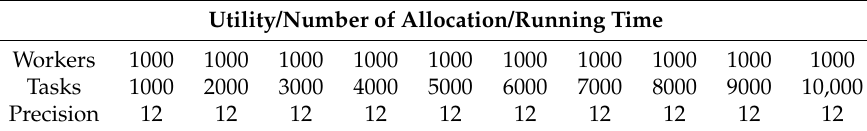
Table 6. Experimental settings for effect of the number of tasks.